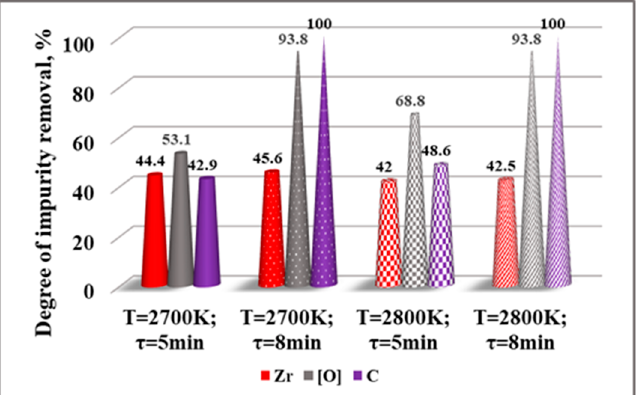
Figure 8. Influence of residence time on the degree of impurity removal at T = 2700 K and T = 2800 K from technogenic hafnium in vacuum.